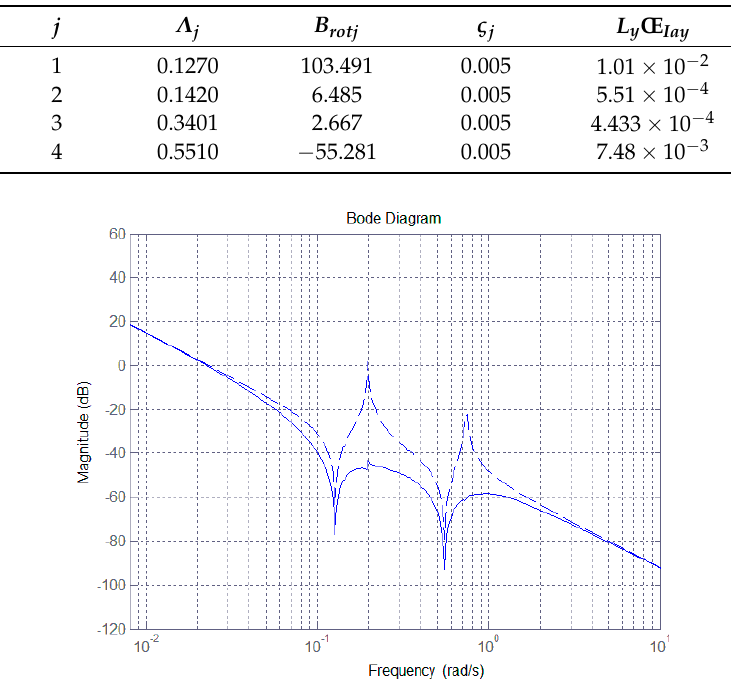
Figure 2. Bode magnitude diagram of satellite and antenna pitch axis.